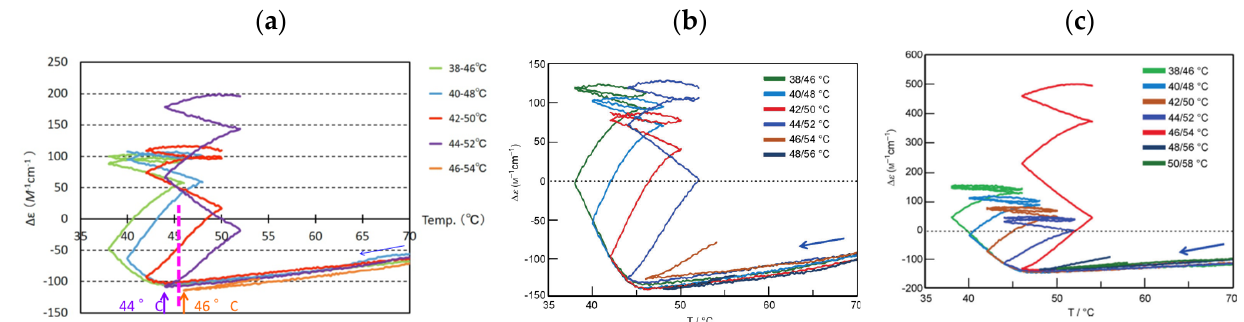
Figure 11. Temperature threshold phenomenon exhibited by ( P )– 1 in 1,3-difluorobenzene at a rate of 0.25 K min –1 at concentrations of ( a ) 0.5 mM, ( b ) 0.6 mM, and ( c ) 0.7 mM. Reproduced from ref. [59] with permission from Wiley.